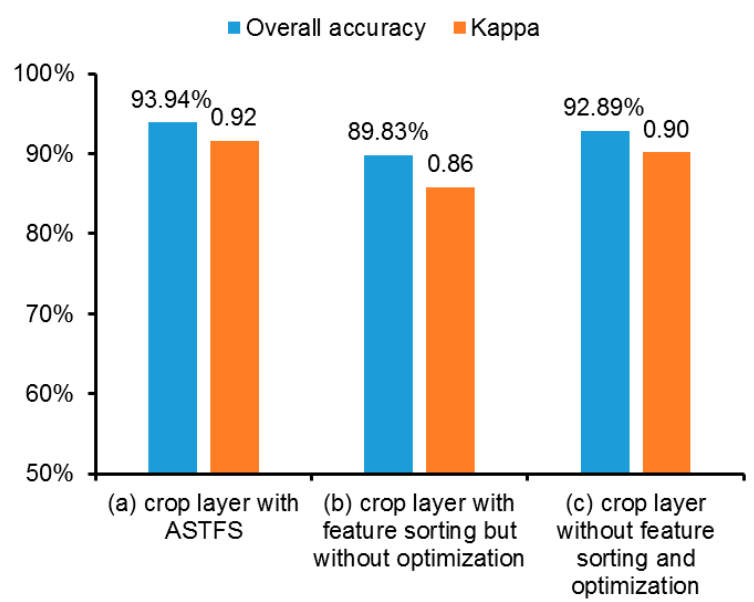
Figure 9. Comparisons of overall accuracies and Kappa coe ffi cients of resultant ( a ) crop layer with ASTFS (using 22 optimal features for rice, 13 optimal features for corn, and 11 optimal features for soybean), ( b ) crop layer with feature sorting but without optimization (using 22 features for rice, 13 features for corn, and 11 features for soybean), and ( c ) crop layer without feature sorting and optimization (using individual 77 features for rice, corn, and soybean). Table 4. Confusion matrix of crop layer with ASTFS.